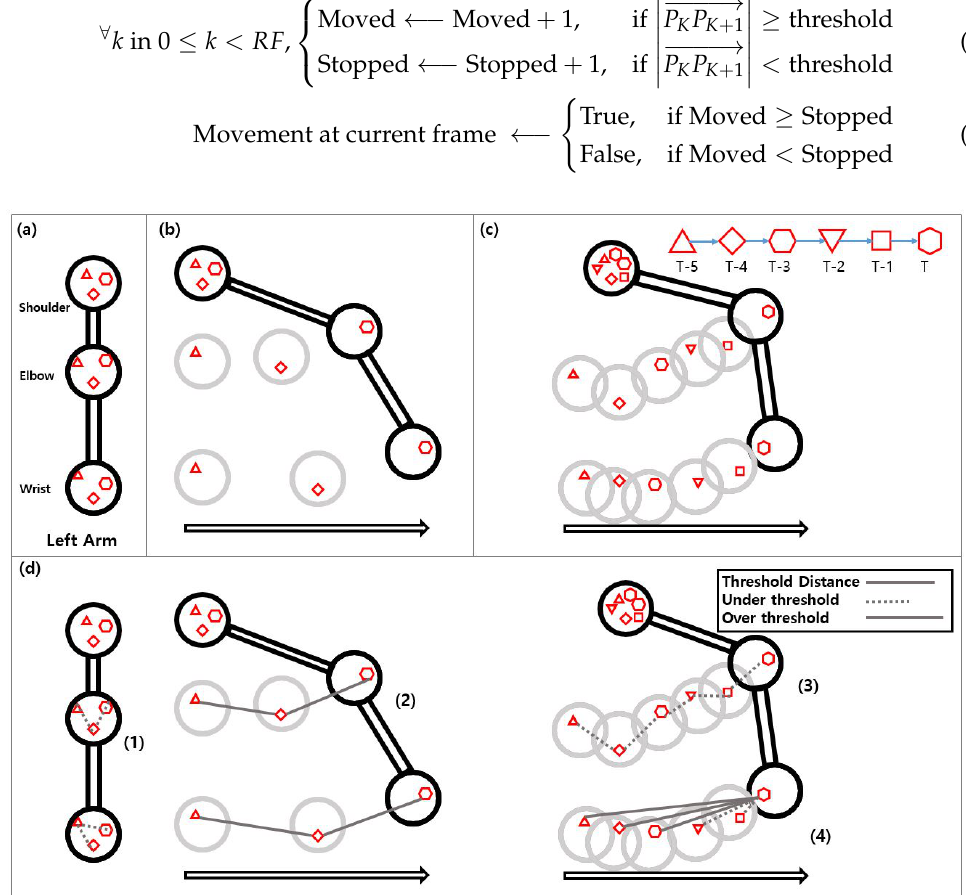
Figure 4. Problem with current MoveNet model and representative solution. ( a ) Natural error in Situation: Stop; ( b ) Situation: Swing right (moving right in 0.1 s, trajectory of 3 frames); ( c ) Situation: Swing right slowly (moving right in 0.2 s, trajectory of 6 frames); ( d ) Comparing solutions: Natural error occurs in ( a ) and each figure’s shoulder point. Dotted lines and solid lines represent whether the length of line is less/greater than threshold. Shapes(triangle to hexagon) represent locus of each point, as shown in ( c